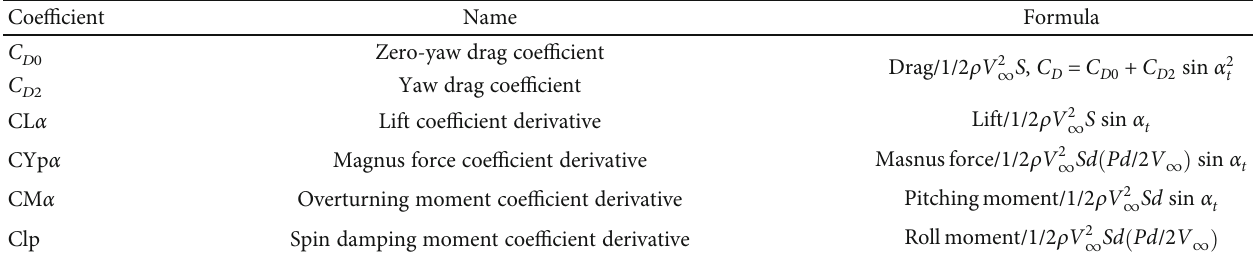
Table 2: Notation and formula of six aerodynamic coe ffi cients.